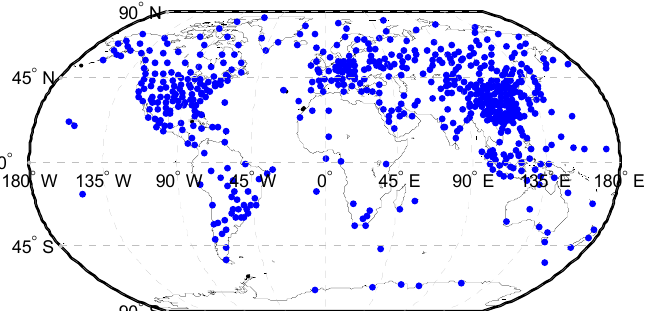
Figure 4. Global high-altitude meteorological station map (each blue dot indicates the station location).